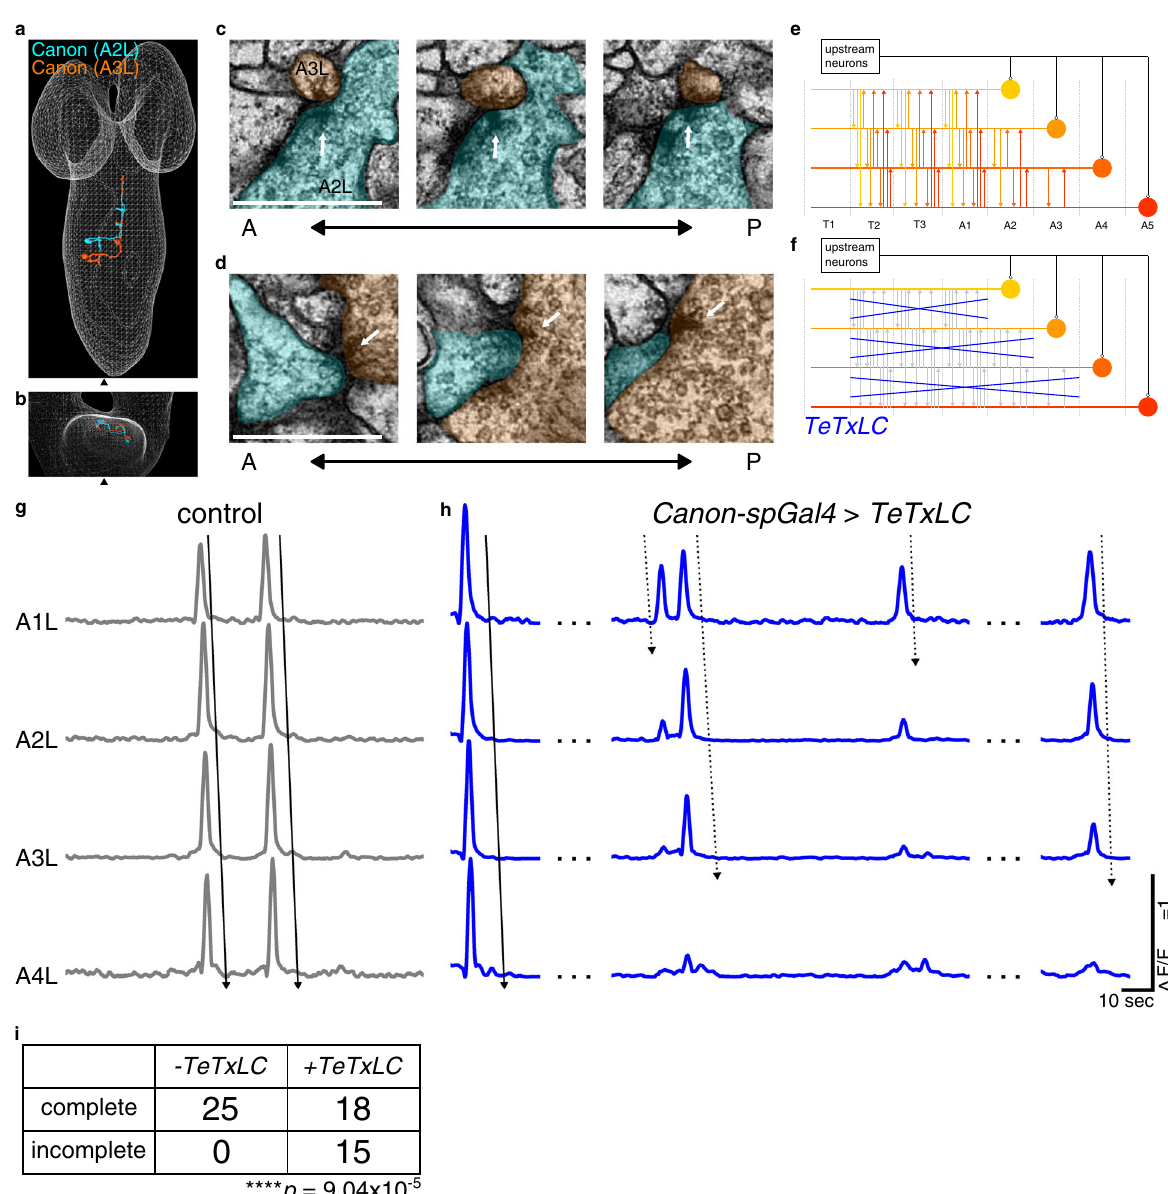
Fig. 6 Canon – Canon network regulates its own wave-like activity. a , b EM reconstructed Canon neurons in A2 and A3. Note that these neurons form a bundle of ascending axons. Dorsal ( a ) and anterior ( b ) view. c , d Serial EM images showing bidirectional synapses between Canon neurons (Cyan: A2, Orange: A3). White arrows indicate T-bars. The images show representative synapses of observed fi ve synapses from A2 to A3 Canon neuron and of observed 13 synapses from A3 to A2 Canon neuron. e , f Schemes of Canon – Canon networks in control ( e ) and Canon > TeTxLC ( f ) larvae. Canon neurons connect with each other via synapses present in their ascending axons. TeTxLC disrupts Canon – Canon transmission but leaves input from other upstream neurons intact. g , h Activity propagation among Canon neurons in control ( g ) and Canon > TeTxLC ( h ) larvae. Arrows with solid lines indicate complete waves, while those with dotted lines indicate incomplete waves. i A cross table showing the number of complete and incomplete waves in the control ( − TeTxLC ) and Canon > TeTxLC ( + TeTxLC ) larvae. The number of incomplete waves is signi fi cantly increased in the experimental group. n = 25 waves in four control larvae and 33 waves in seven experimental larvae. **** p < 0.0001. p = 9.04 × 10 − 5 , the one-sided chi-squared test. Scale bars, 500 nm ( c , d